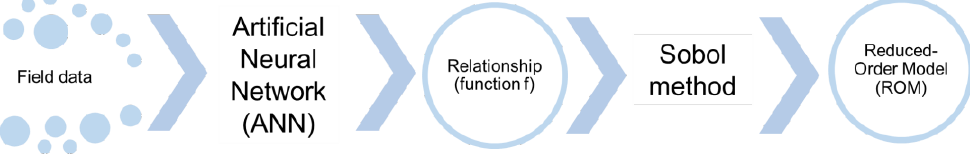
Figure 1. Approach for creating ROM from field data for this